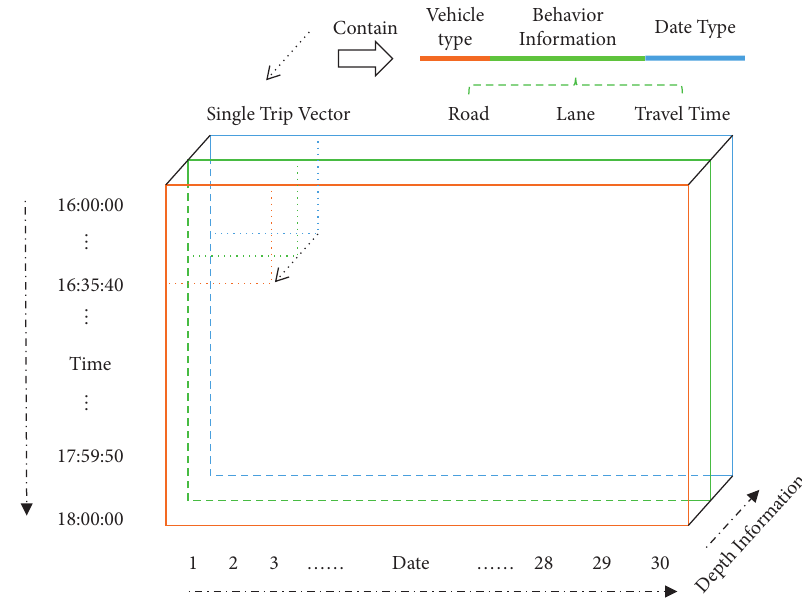
Figure 5: Multidimensional individual traffic behaviour